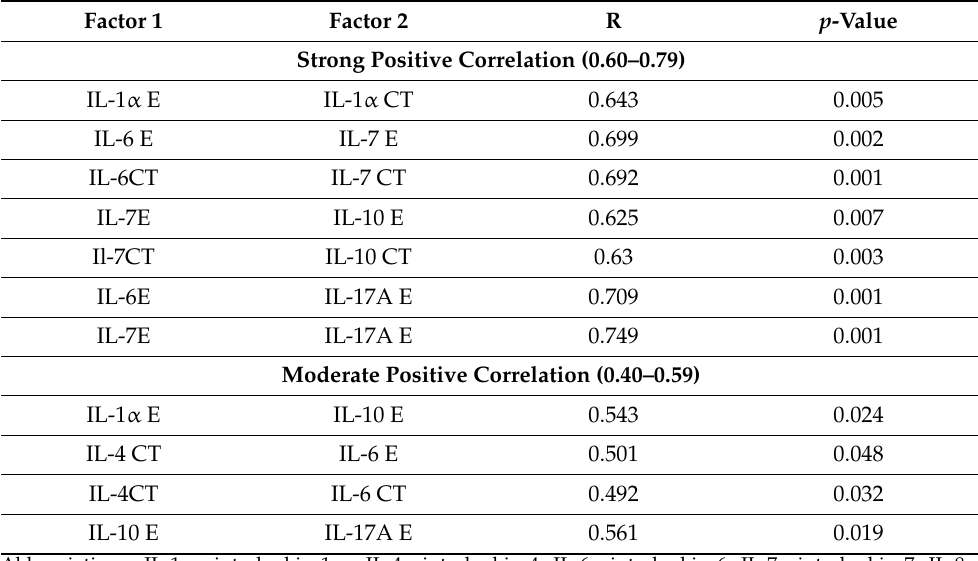
Table 4. Spearman’s rank correlation coefficient revealing correlations between different interleukins in connective tissue and